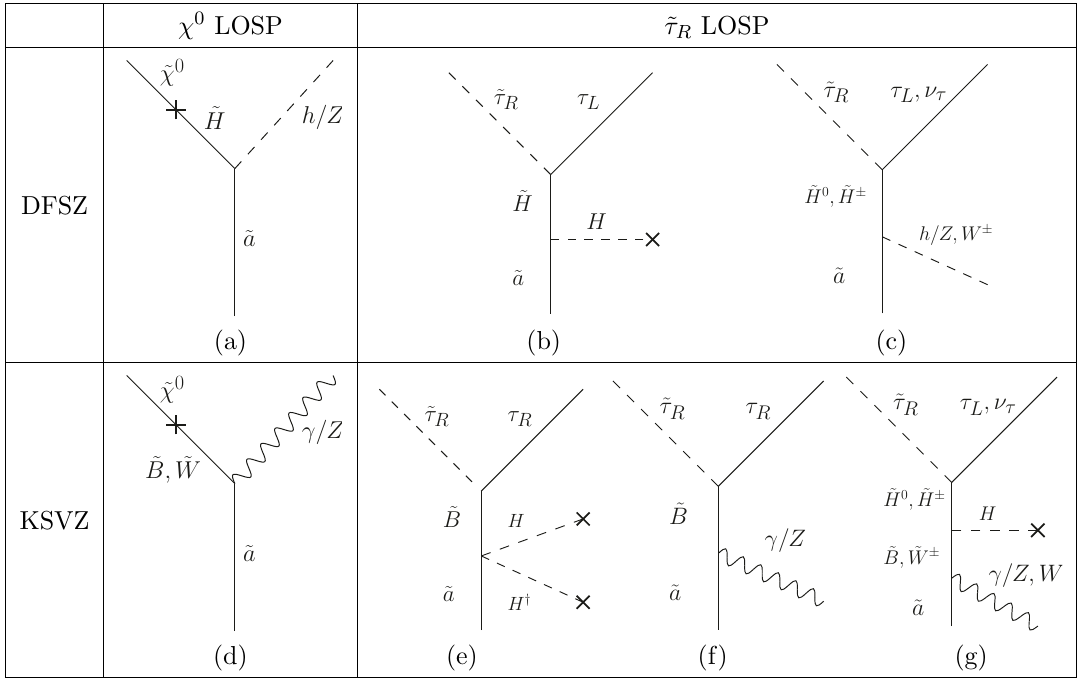
Table 1 . Displaced signals from ~ (cid:31) 0 and ~ (cid:28) R LOSPs decaying to NLSP